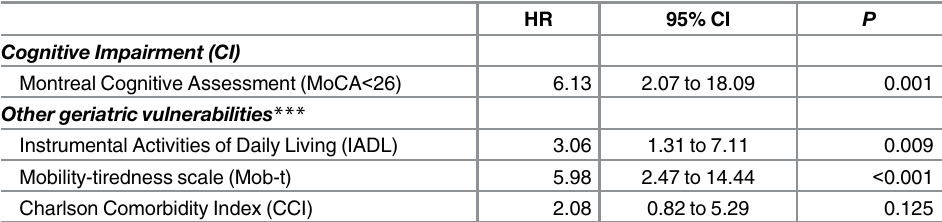
Table 4. Associations between Cognitive Impairment (CI) and other geriatric vulnerabilities of older patients at the time of cancer treatment initiation, and two-year survival * : Multivariate Cox regres- sions stratified for diagnosis and disease status **